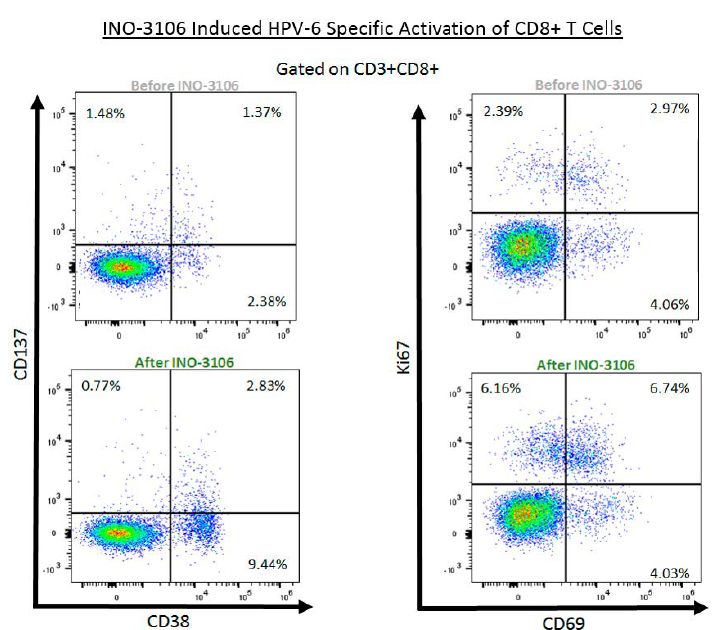
Figure 3. INO-3106 Activates HPV6-specific cytotoxic lymphocytes cells in RRP patients. Flow cytometry was performed to assess activation marker expression on HPV6-specific CD8+ T cells taken from patients before and after immunotherapy. Expression of CD137 and CD38 before (upper panel) and after (lower panel) treatment with INO-3106 in patient 604 are noted in the left column. Expression of Ki67 and CD69 before (upper panel) and after (lower panel) treatment with INO-3106 in patient 604 are noted in the right column.